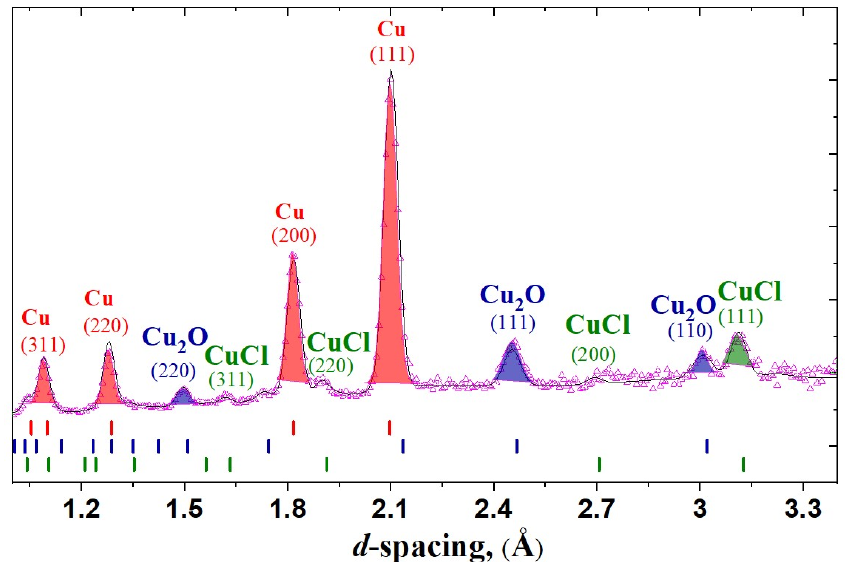
Figure 1. An example of the neutron diffraction patterns of coin MP467, for which the experimental points and fitted profile are shown. Tick marks are the calculated positions of the Bragg peaks of the copper, copper oxide and copper chloride phases. The most intense diffraction peaks of those phases with hkl-indexes are labeled.